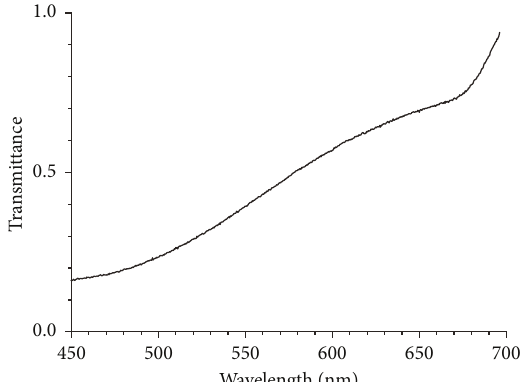
Figure 3: Transmittance spectrum of the two volume Bragg gratings placed in the detection path (VBGs 3 and 4 in Figure (1)). Fluorescence spectra measured with our apparatus must be calibrated using this transmittance spectrum.